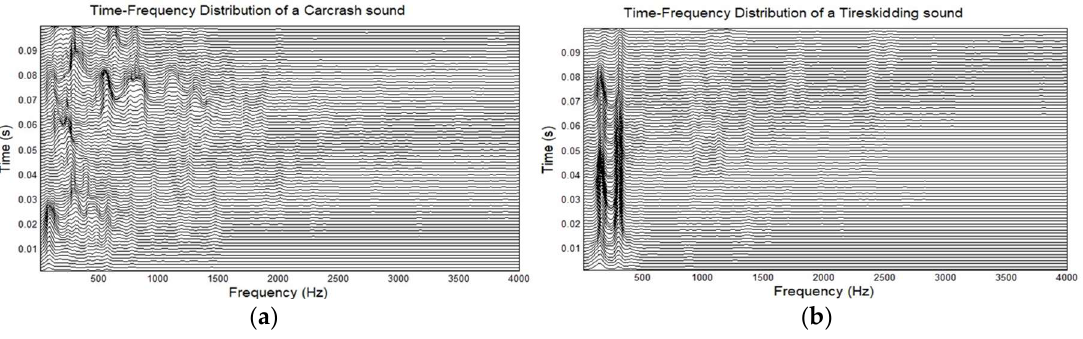
Figure 5. Illustration of higher entropy and flux measures for event ( a ) CC than event ( b ) TS. Table 6. Comparison of recognition rate achieved between the three typologies of features.